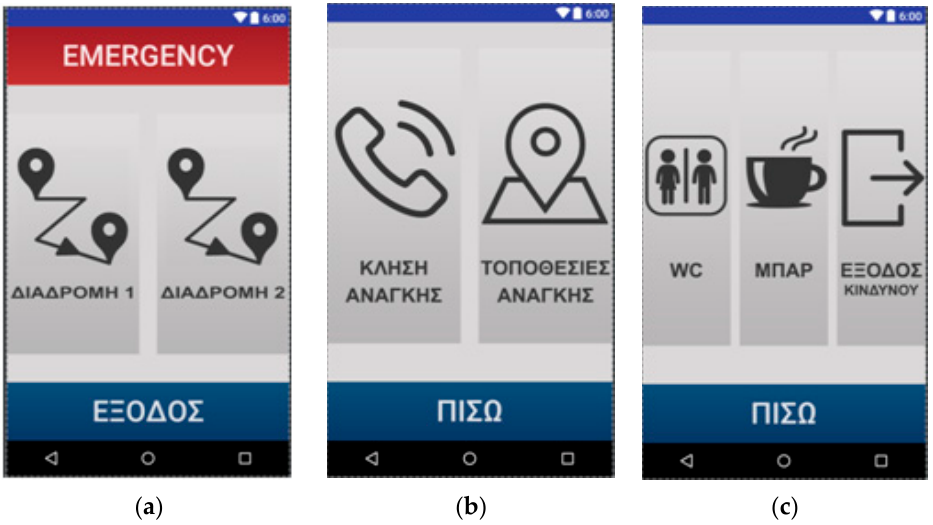
Figure 5. Blind MuseumTourer Android application activities: ( a ) Route selection; Selecting a route initiates the self-guided tour activity using a Guide Map of the indoor space (see Figure 4b); ( b ) Ask help; ( c ) Get voice way-finding instructions to move to the WC/canteen/exit.